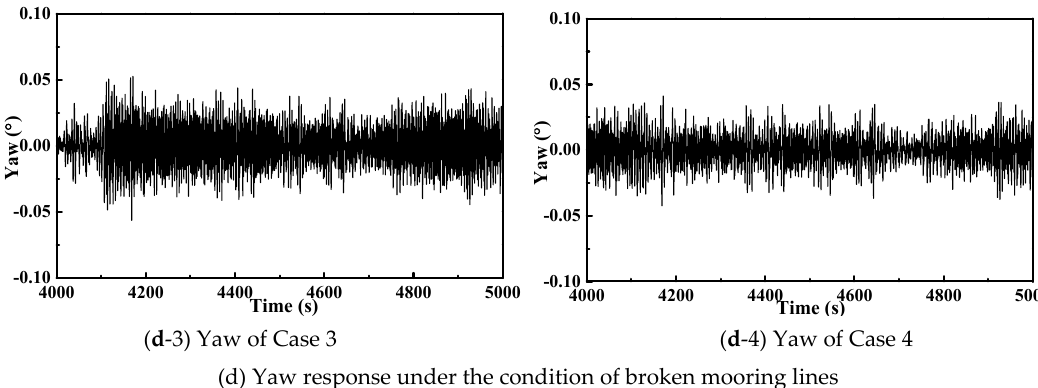
Figure 21. Time series of the platform motion under the condition of broken mooring lines.